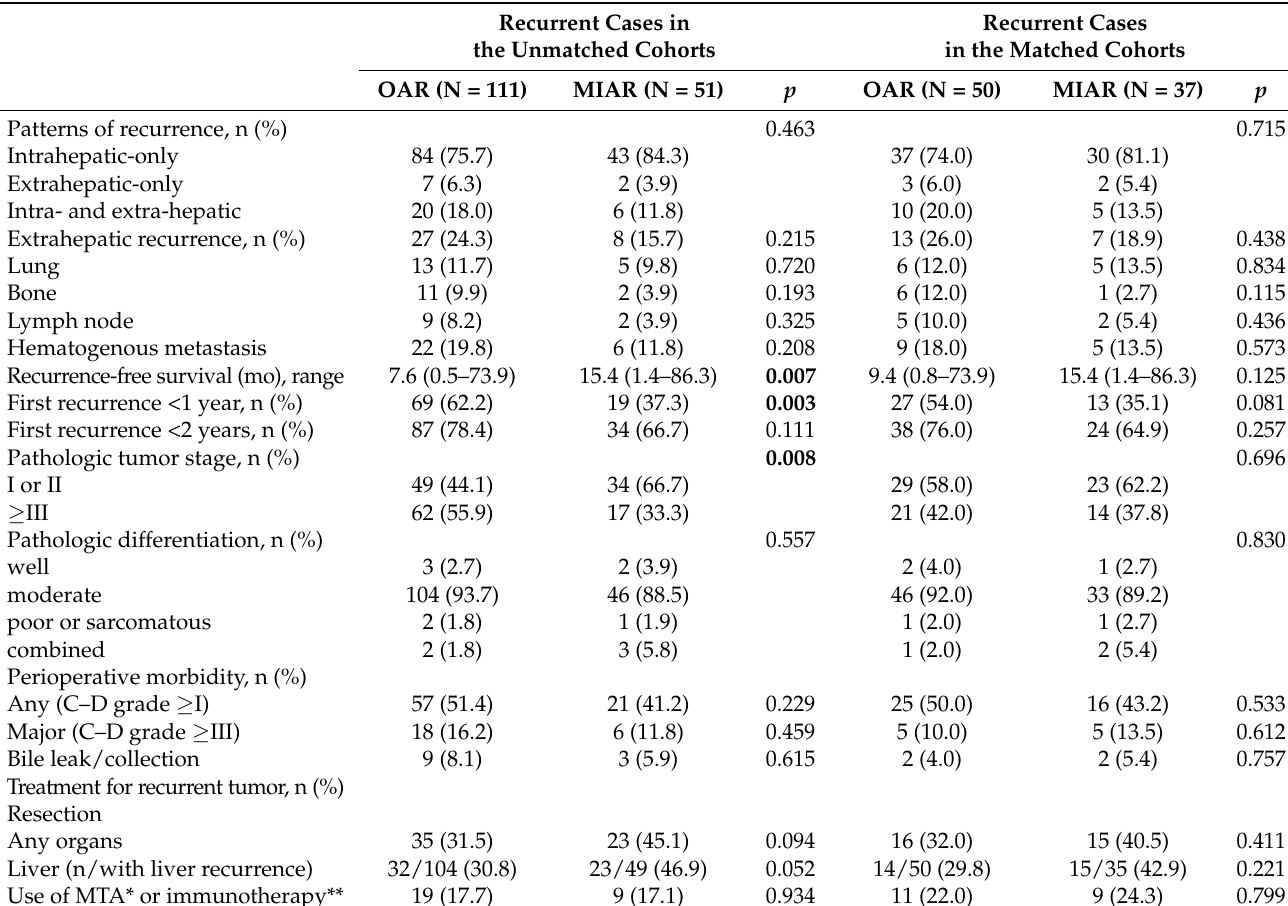
Table 7. Details of recurrence after OAR or MIAR for newly developed